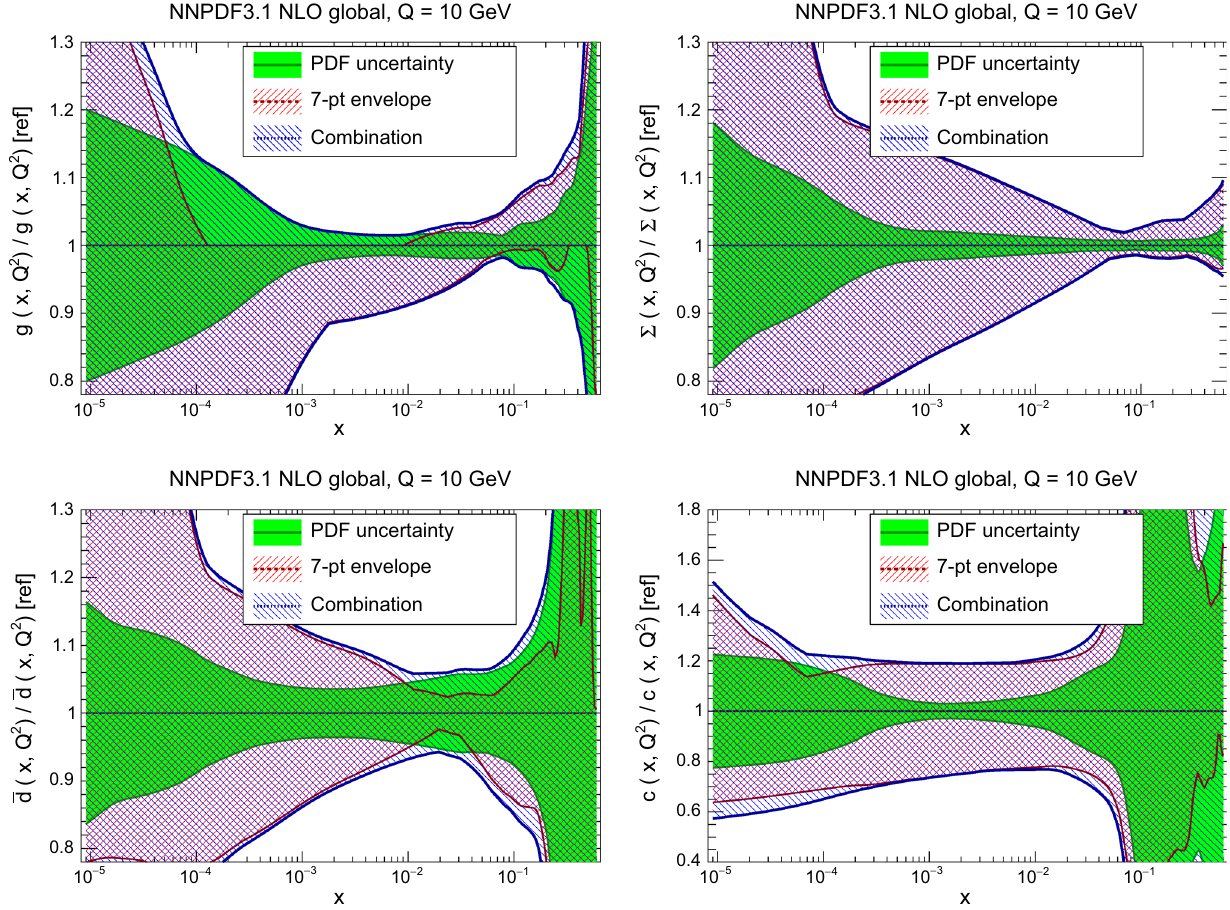
Fig. 27 The PDF uncertainties Eq. (B.3): the PDF uncertainty σ PDF computed using standard NNPDF methodology, the 7-point envelope estimate of the MHO uncertainty σ mho , ± and the total combined uncer-